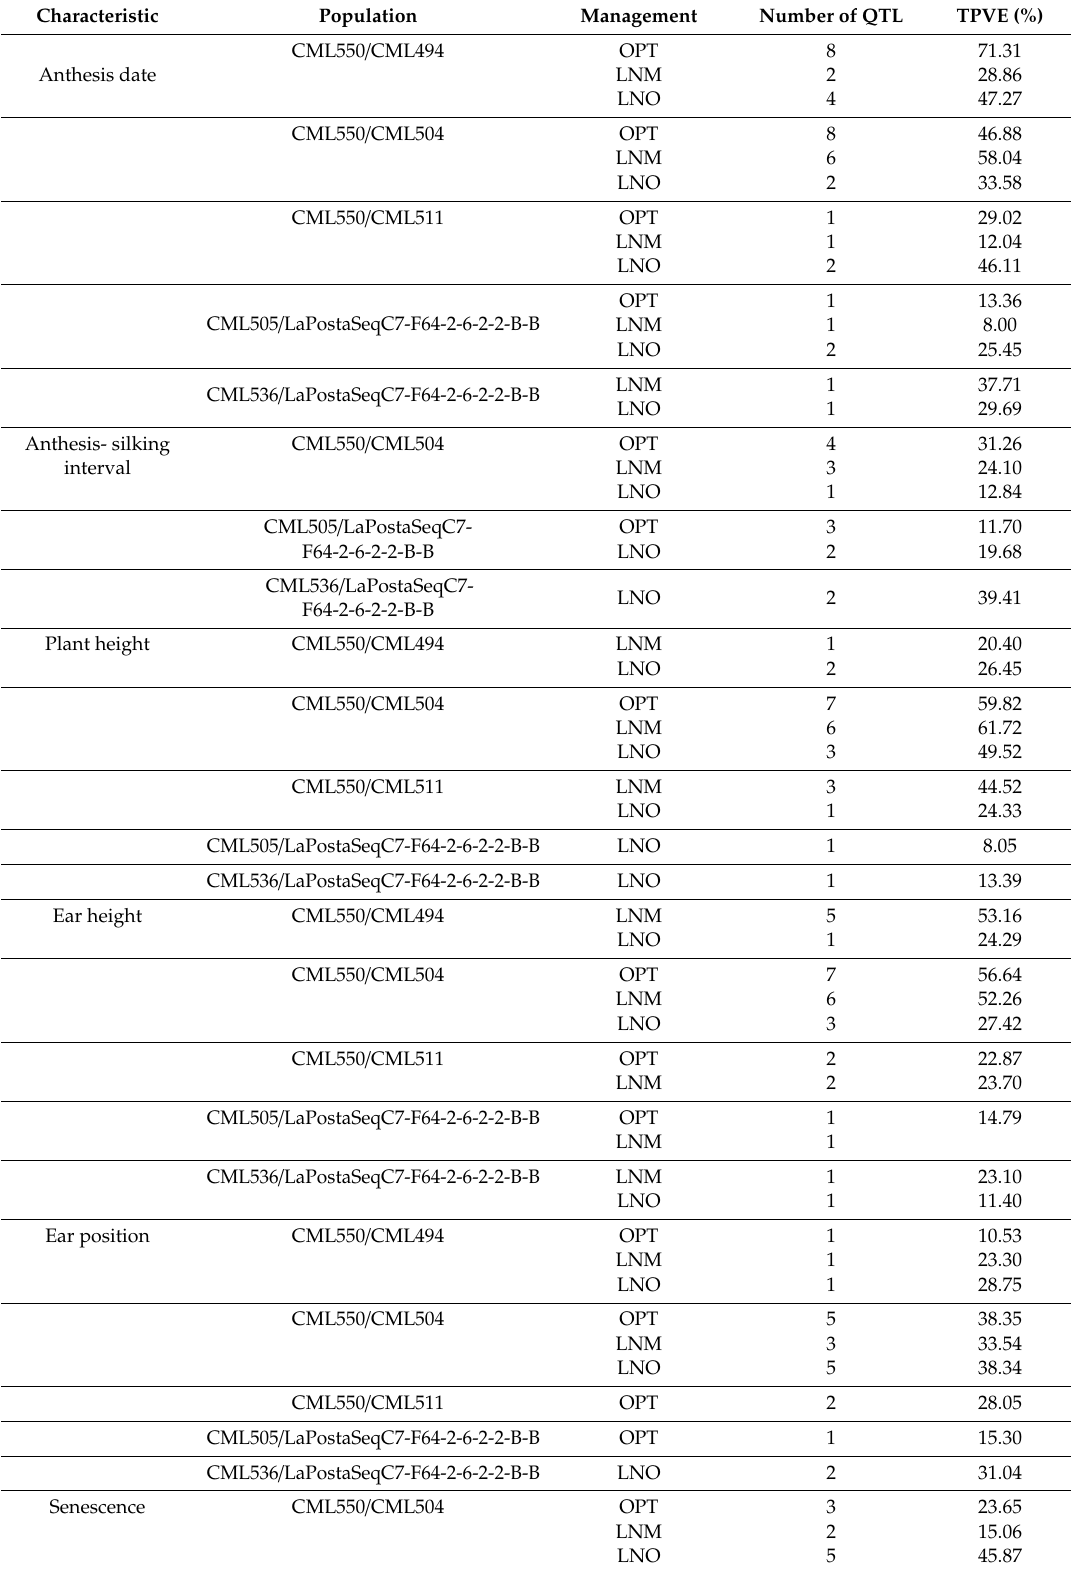
Table 4. Summary of detected QTL for measured characteristics under optimum and low-nitrogen stress in main season (LNM) and o ff -season (LNO) in DH lines derived from five bi-parental populations.